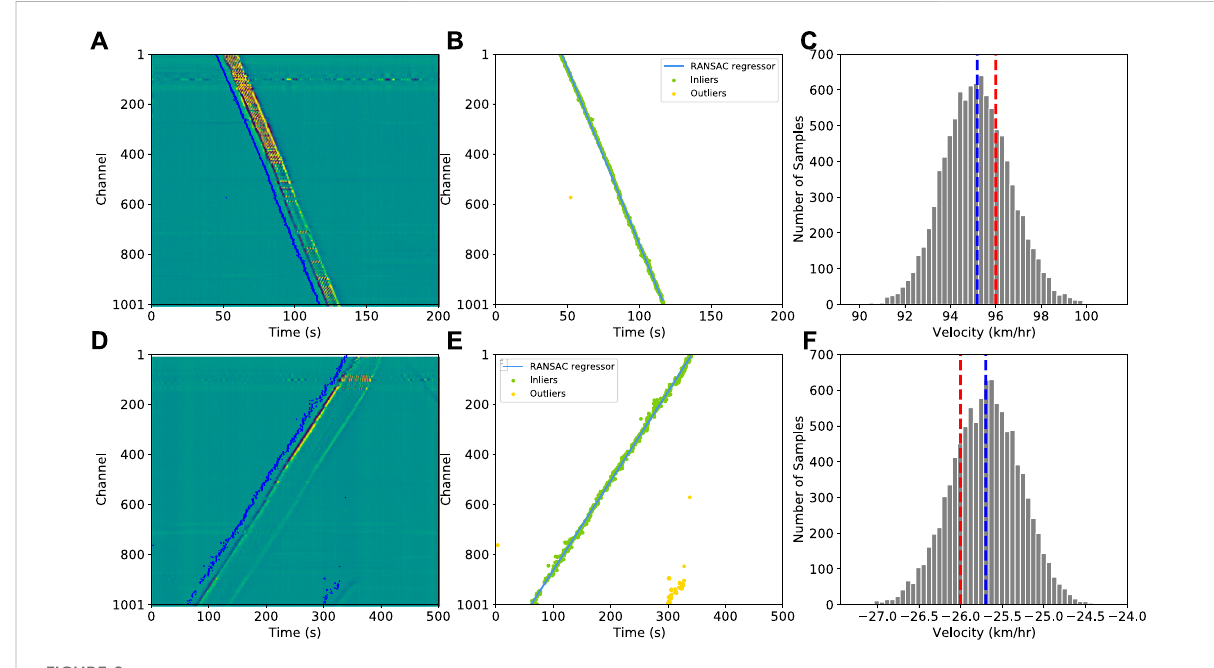
FIGURE 8 Examples of RANSAC linear regression on the relative travel times for EMU train and conventional train cases. (A) EMU train case and relative travel times (blue dots) picked by cross-correlation of signal envelopes; (B) RASAC regressor fi tting the inliers, outliers excluded automatically; (C) Histogram of bootstrapped speeds, the red and blue dotted lines denote the beamformed speed obtained by our method and mean speed, respectively; (D – F) Same as (A – C) , but for a conventional train